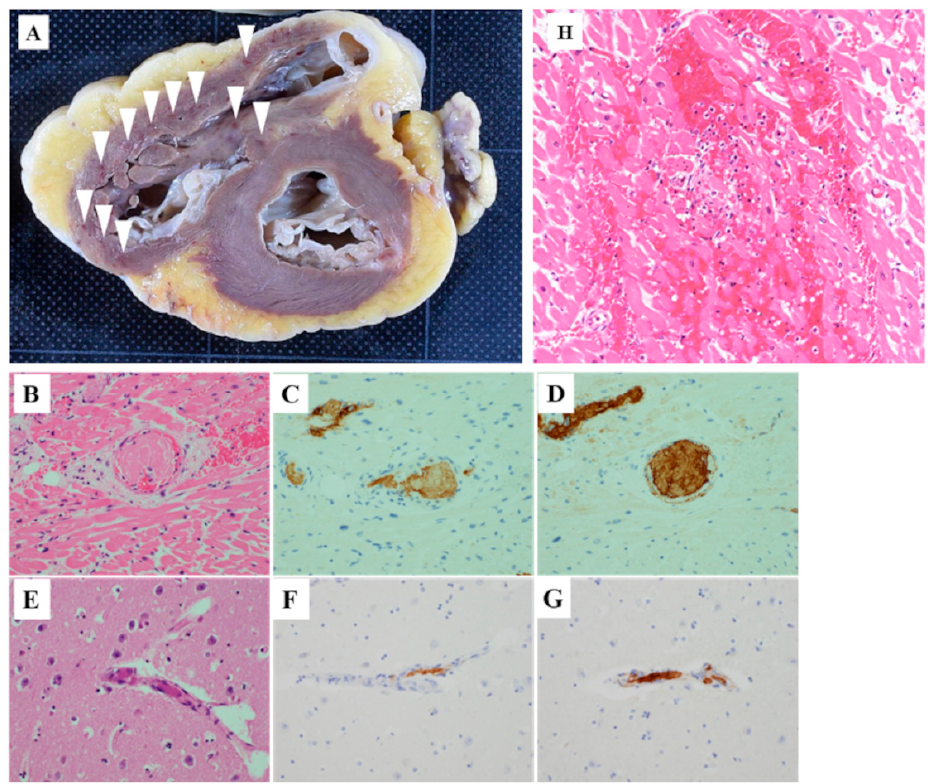
Figure 2. ( A ) Macroscopic findings of the heart. Many petechial hemorrhagic lesions were observed in the right ventricle wall (arrowhead). ( B – G ) Postmortem pathological findings of the heart and brain. Hematoxylin-eosin staining of the heart showed microthrombi in the small blood vessels with focal hemorrhaging in the surrounding myocardium ( B ). The cells were slightly fibrin-positive ( C ) and markedly VWF-positive ( D ) (magnification: 200 × ). Similarly, hematoxylin-eosin staining of the brain also revealed occlusive thrombi ( E ). The thrombi were slightly fibrin-positive ( F ) and markedly VWF-positive ( G ) (magnification: 200×). Bleeding and necrosis of cardiomyocytes and inflammatory cell infiltration ( H ) (magnification: 200×).